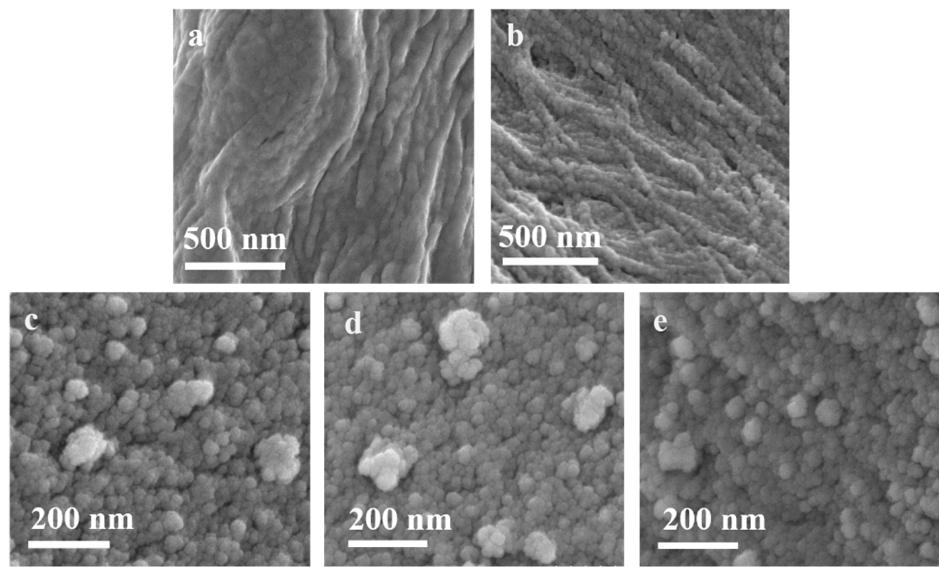
Figure 3. SEM images of ( a ) DD45, ( b ) DD75, ( c ) Pt-T200, ( d ) Pt-10%DD45-T200, and ( e ) Pt-10%DD75-T200.